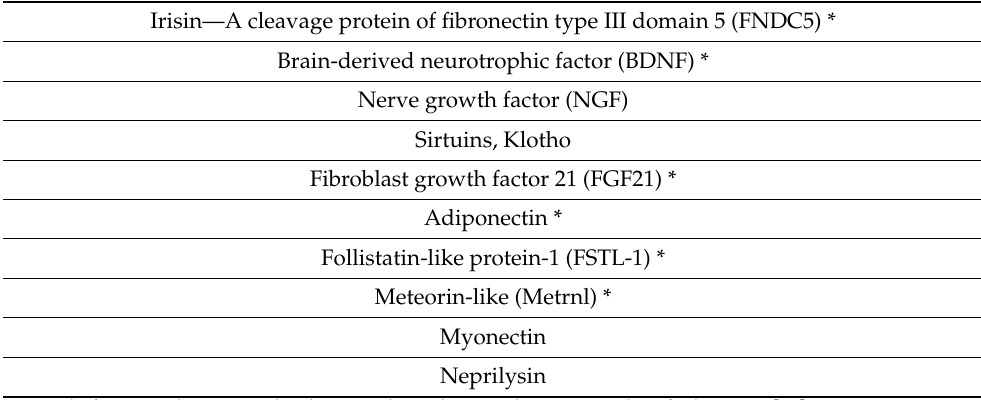
Table 5. A selective list of the metabotrophic effects of NGF, BDNF and adiponectin (APN) *. NGF shares homology with proinsulin NGF and BDNF are trophic factors for pancreatic beta cells APN is an anti-obesity, anti-diabetogenic, anti-atherogenic adipokine NGF, BDNF and APN deficiency led to the development of obesity and related